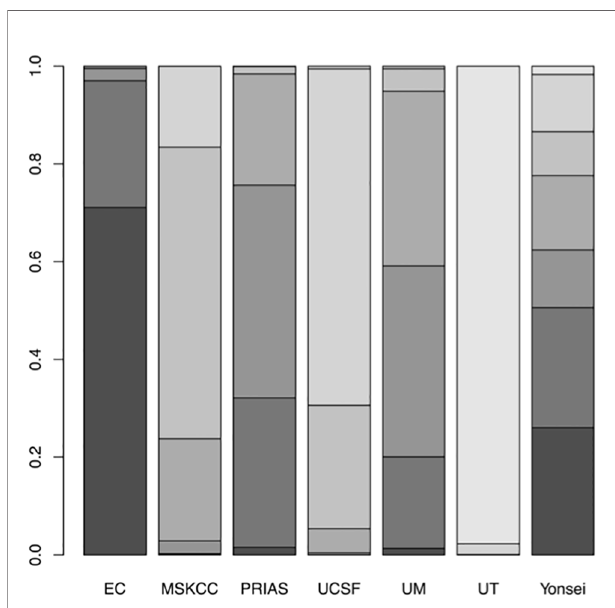
FIGURE 4 | Surface under the cumulative ranking (SUCRA) plot of the 7 included AS protocols. A darker color is proportional to a better performance in predicting insigPCa.